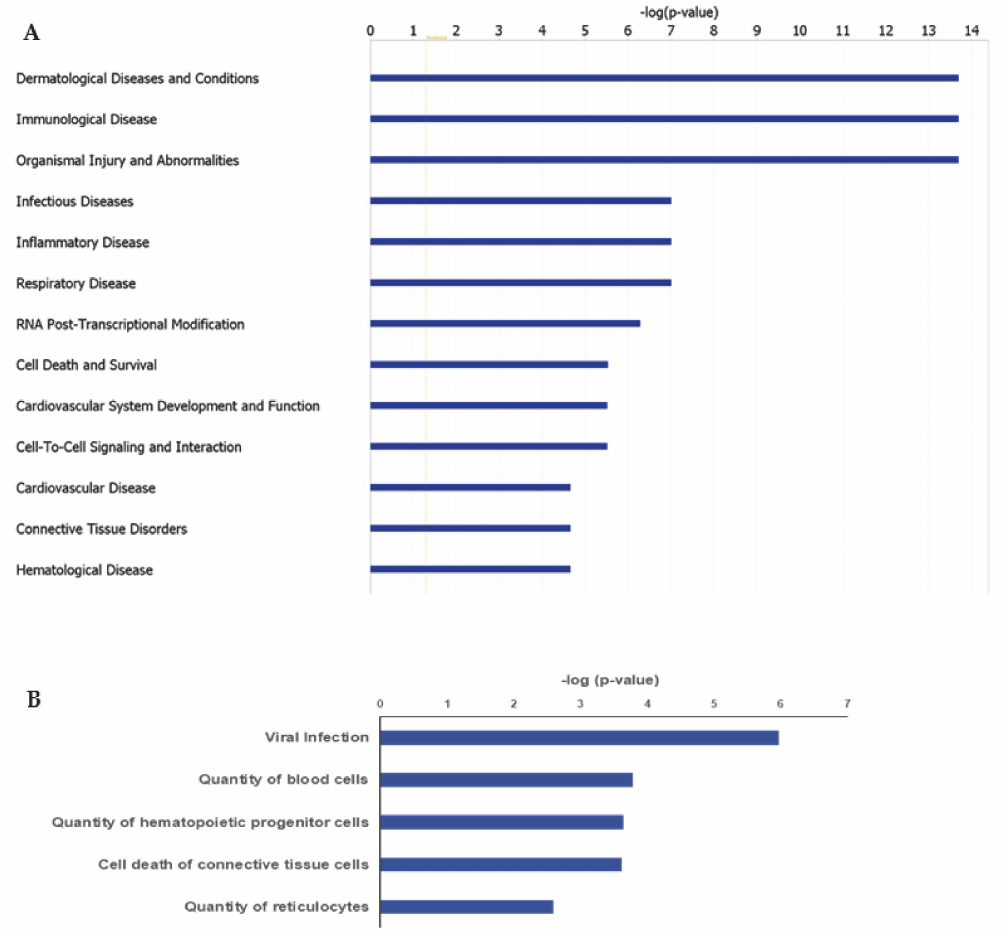
Figure 2. Ingenuity Pathway Analysis (IPA): Illustrated are the top-scoring diseases ( A ) and biological functions ( B ) based on differentially expressed genes in MKD patients. Blue bars in ( B ) refer to a negative z